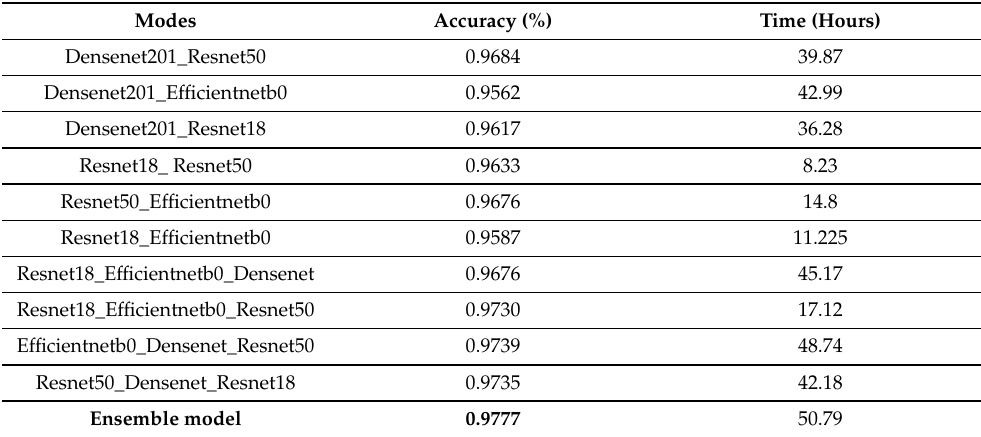
Table 9. Performance of the different combination of baseline